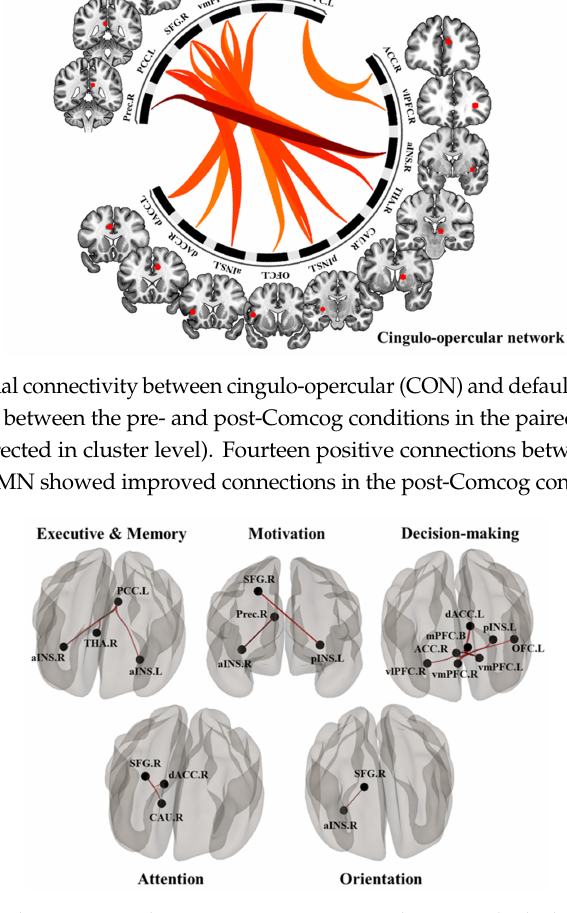
Figure 3. The functional connectivity among ROIs was associated with neurocognitive abilities after CCT training. In the partial correlation analysis, the connectivity between brain structures in core cognitive brain networks was positively correlated with neurobehavioral test scores.